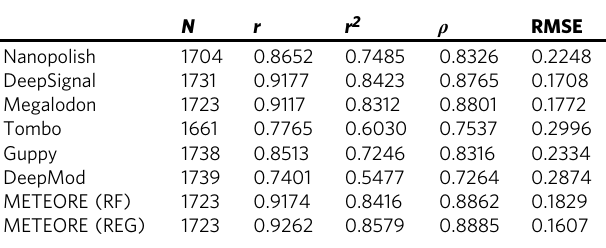
Table 1 Comparison of CpG methylation frequencies from whole-genome bisul fi te sequencing (WGBS) and from Cas9- targeted nanopore